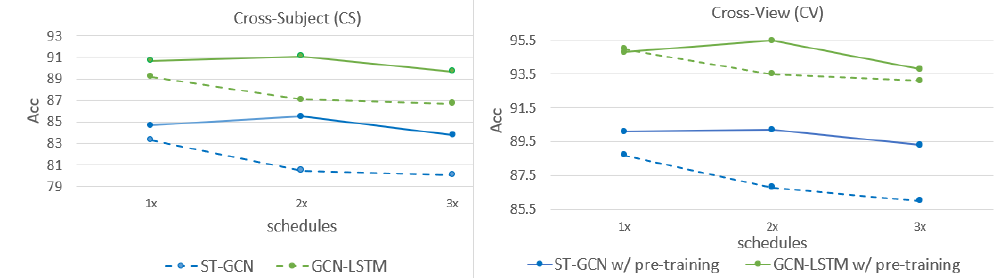
Figure 5. Comparison in terms of interaction recognition accuracy of models w/ and w/o pre-training on the NTU60 dataset. schedules means the training